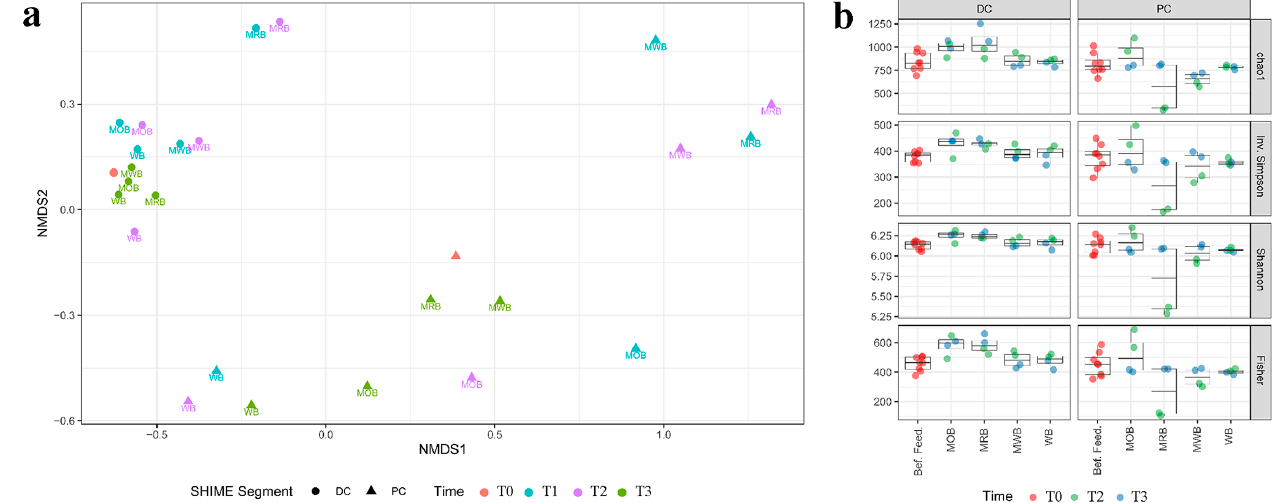
Figure 4. NMDS analysis ( a ) of the beta diversity within sample microbiota based on Bray–Curtis distance matrix of the luminal 4-SHIME ® samples before feeding (T0), during 1 (T1) and 2 (T2) weeks of feeding with MOB, MRB, MWB and WB, and after the wash out period (T3). The analysis considered sample inter-diversity of both PC and DC tracts. Alpha diversity ( b ) within the samples determined with Chao1, Gini Simpson, inverse Simpson, Shannon and Fisher indexes of microbiota in different colon tracts and at different time points for each formulation.